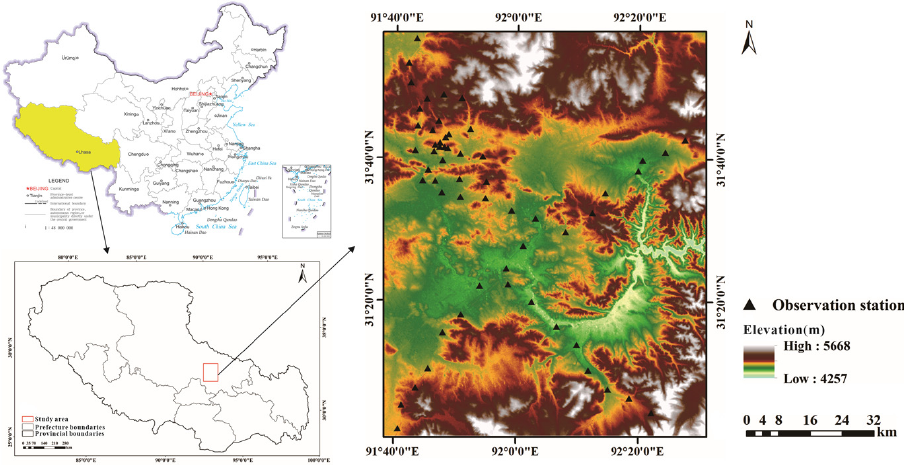
Figure 9. The location of the Naqu test site.